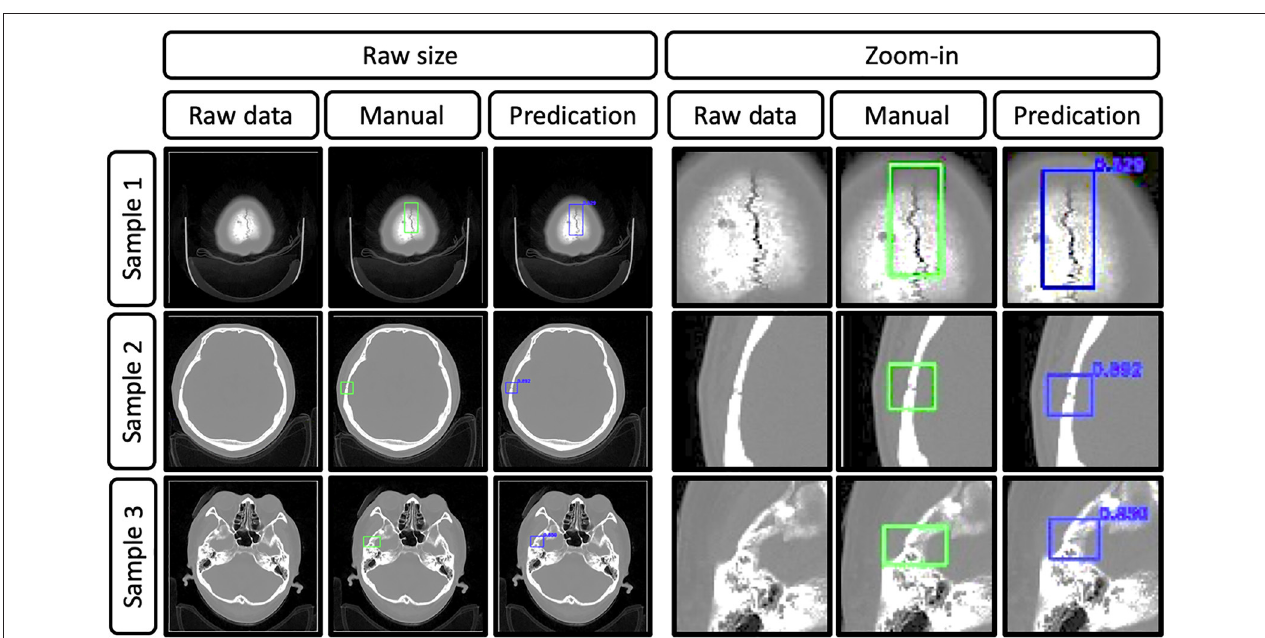
FIGURE 4 | Representative images show the raw data of skull fractures based on CT bone algorithm sequence slices, manual skull fracture labeling, and prediction (by the YOLOv3 network). Samples 1, 2, and 3 were from different patients, and the Dice scores were 0.829, 0.892, and 0.850, respectively.